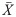
Model fit to influenza observations.Scaled observed syndromic+ observations (O1:33) for A(H1) throughout the 2012–13 season are shown as points; blue lines represent inferred model incidence (X1:33). Note that, because each timepoint is fit based on activity in all countries with observations, fits are shown for a country even for weeks where that particular country had no available observation. Each line represents the mean inferred model incidence over 300 ensemble members for one of five model runs, each with different starting conditions; 95% confidence intervals (calculated using the ensemble mean, X¯, and standard deviation, σ, as X¯±1.96∙σ) for each run are shown in gray. The root mean square error (RMSE) for this season and (sub)type varied between 60.36 (ES) and 642.99 (LU), and the mean RMSE over all countries was 241.33 (median = 200.09). Pearson’s correlation coefficients ranged from 0.920 (HU) to 0.993 (CZ), with a mean correlation coefficient of 0.973 (median = 0.982).